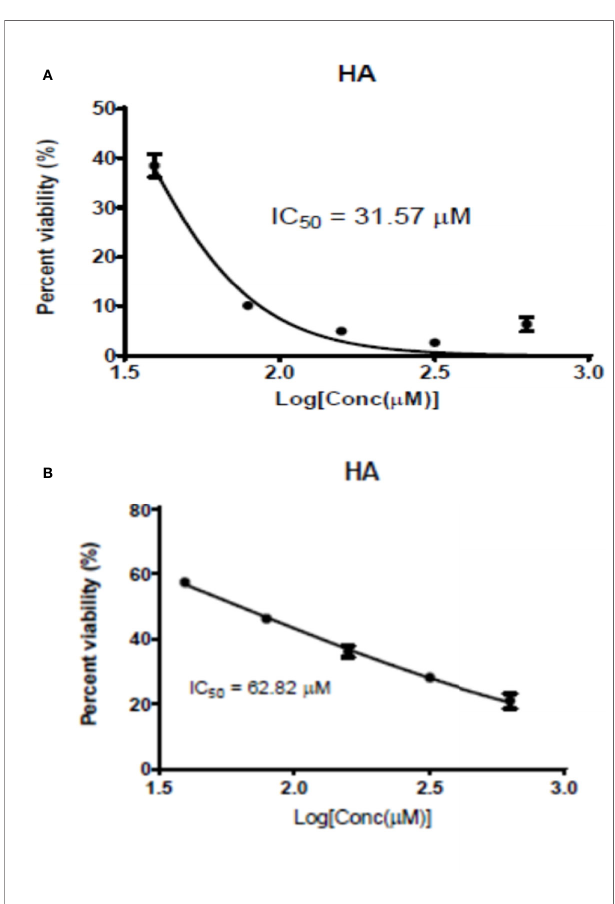
FIGURE 2 | Graphic 1: Dose-response activity of HA on L. major (A) and on L. donovani (B)